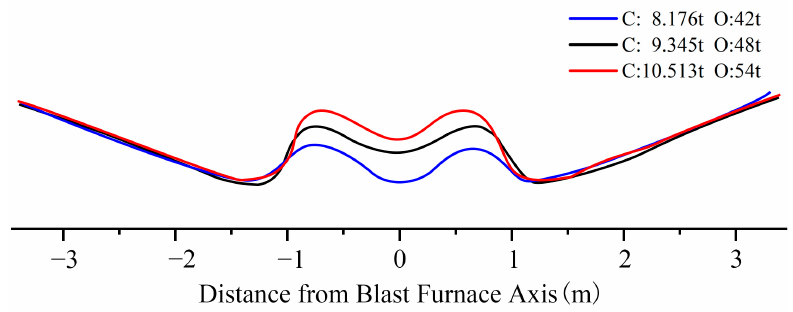
Figure 13. Shape of the ore-free zone with different coke and ore batch weights. Table 10. Width and thickness of the ore-free zone under di ff erent coke and ore batch weights. Batch Weight (t)